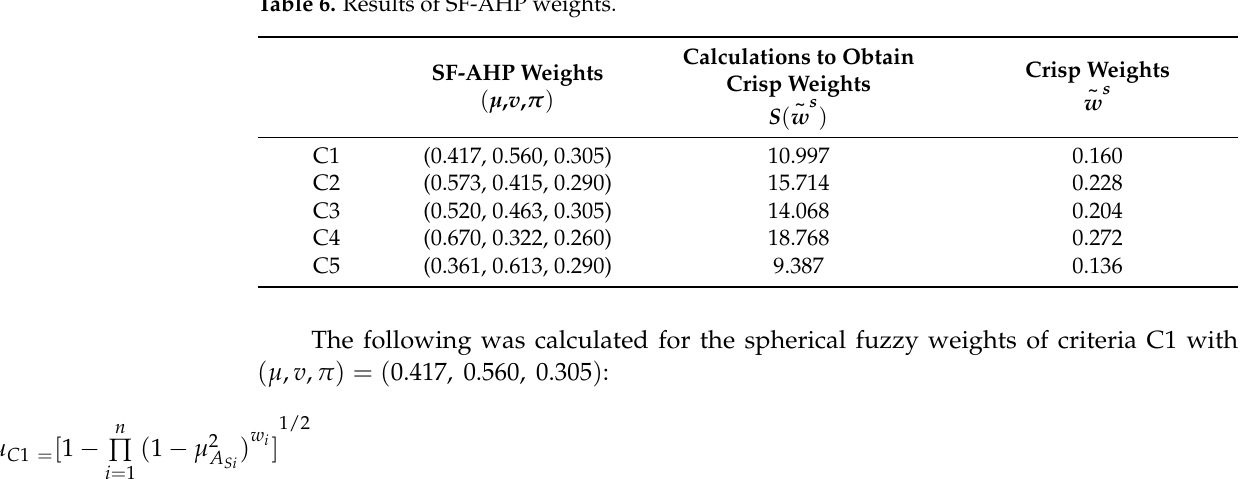
Table 6. Results of SF-AHP